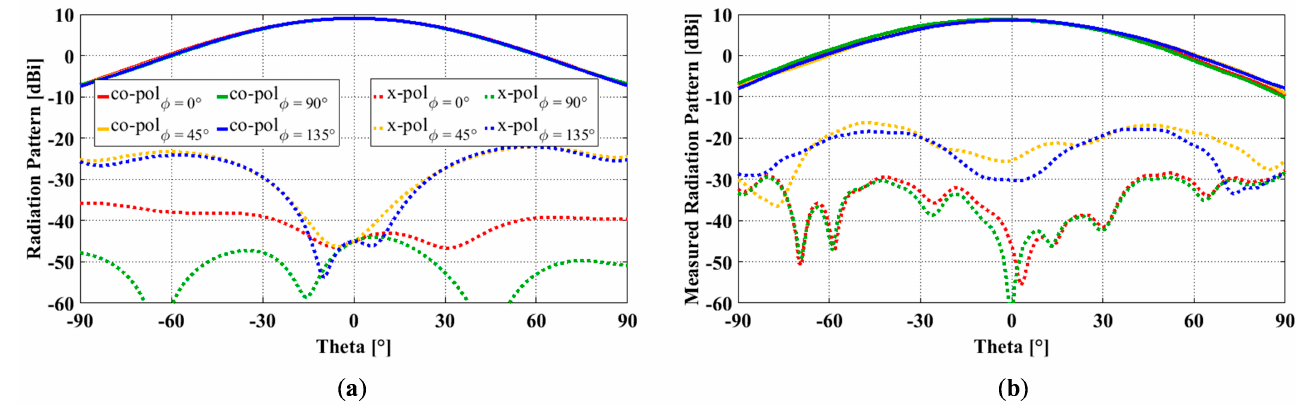
Figure 11. OCROP radiation patterns at 1.5 GHz: ( a ) Simulated results; ( b ) Measured